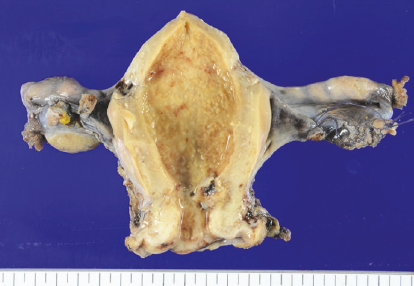
Figure 2: The specimen from the operation. There was a 1.5cm brownish mass with an unclear border with the stroma on the uterine corpus side of the cervix.